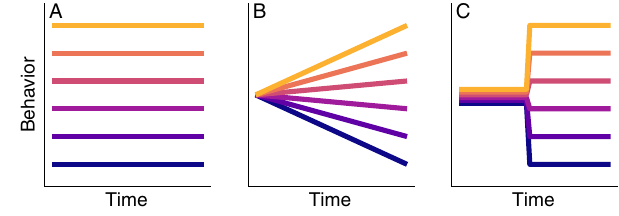
Fig. 1 | Three stylized scenarios of how individuality can emerge. Individuality might be present at birth ( A ) or emerge gradually ( B ) or in an abrupt fashion ( C ) after birth (see main text for details).